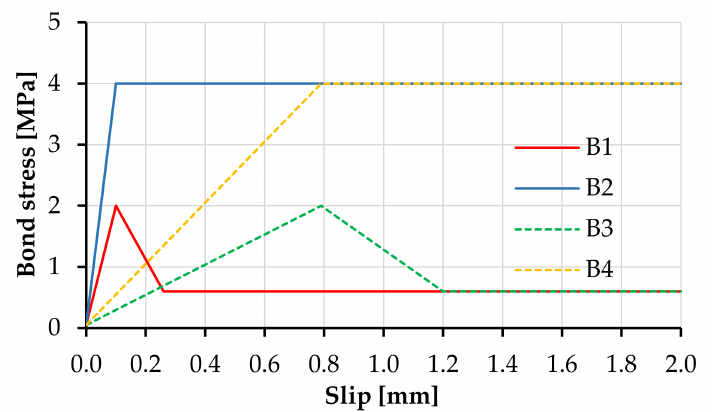
Figure 4. Numerical bond stress-slip laws of the continuous reinforcement.